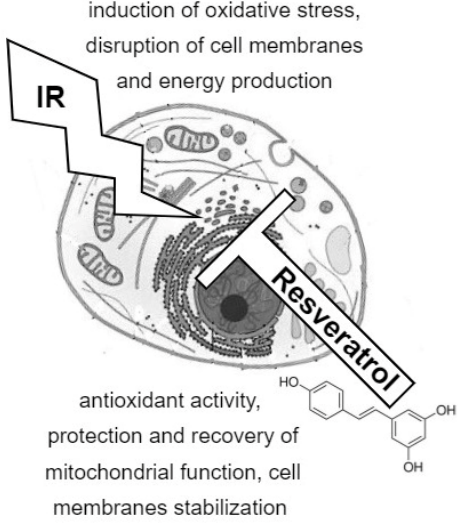
Figure 2. Hypothetical metabolism-related mechanism of radioprotection by resveratrol: main mechanisms of radiation toxicity and protective effects of resveratrol. IR—ionizing radiation.